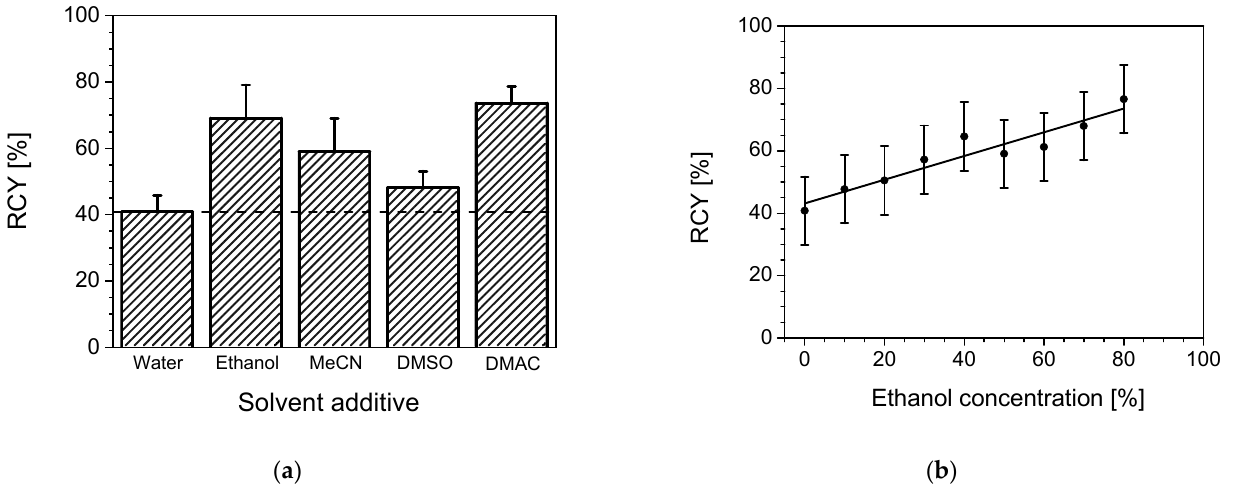
Figure 4. ( a ) Influence of different solvents substitutes on the yield of 18 F labelling. Fifty per cent of the reaction solvent water were replaced by the following solvents: ethanol, acetonitrile, dimethylsulfoxide (DMSO), and N,N-dimethylacetamide (DMAC). Reaction parameters: 0.2 mM [Al(OH)(NODA*)], 0.15 M of NH 4 OAc-buffer pH 4.5, 105 °C, total volume of 100 µL with water/solvent = 50:50, 20-min reaction time. Error bars are only shown in the up direction. ( b ) Influence of the concentration of the chosen solvent ethanol (in % of total volume) in water on the RCY. Reaction parameters: 0.2 mM [Al(OH)(NODA*)], 1.5 M of NH 4 OAc-buffer pH 4.5, 105 °C, 20-min reaction time, total volume of 100 µL, 80 µL thereof with different EtOH/water ratios ( v / v ). The Pearson correlation coefficient is R = 0.9481.